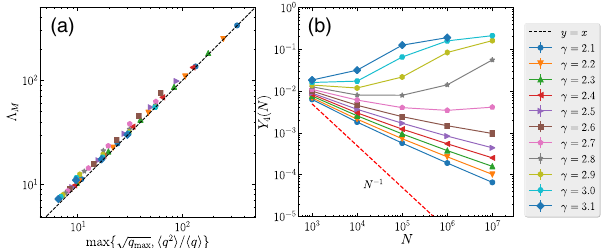
FIG. 1. (a) Largest eigenvalue Λ as a function of ffiffiffiffiffiffiffiffiffi M p ; h q 2 i = h q ig in uncorrelated power-law UCM net- q max f max works with different degree exponent γ and network size N . (b) Inverse participation ratio Y 4 ð N Þ as a function of N in uncorrelated power-law UCM networks with different degree exponent γ . Each point in both graphs corresponds to an average over 100 independent network realizations. Error bars are smaller than symbol sizes. Networks have a minimum degree m ¼ 3